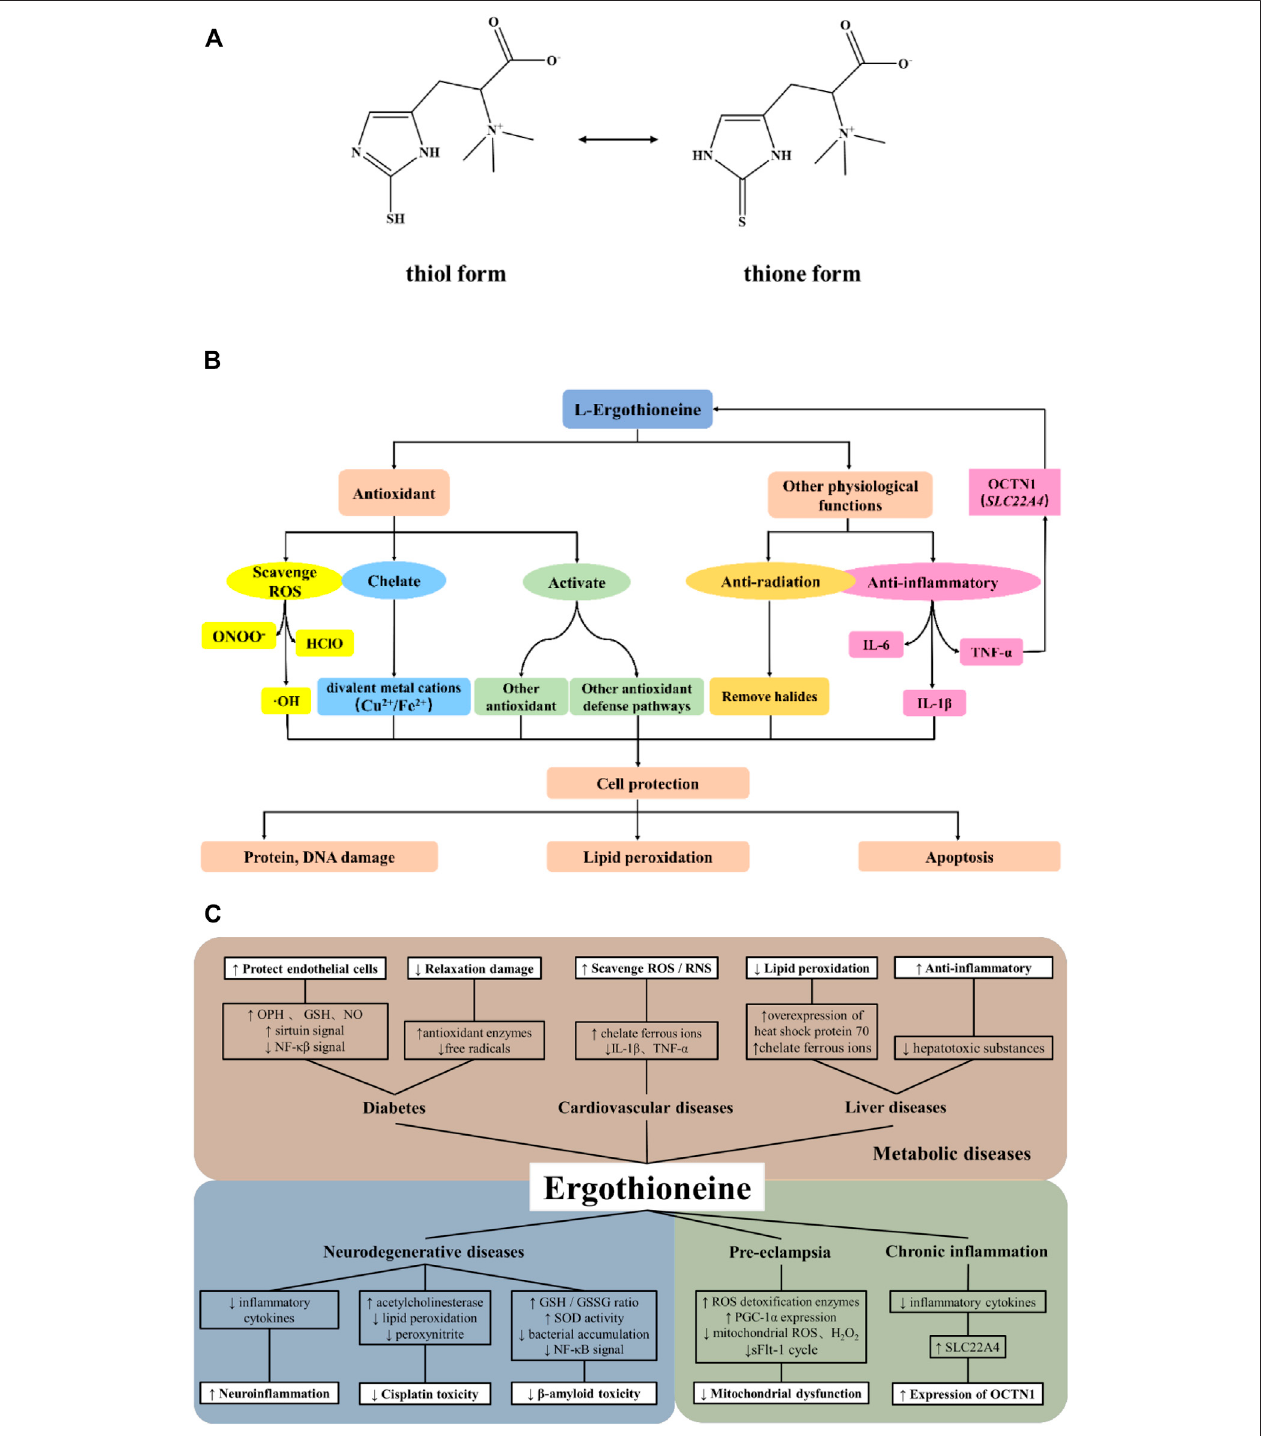
FIGURE1| Antioxidantpropertiesandpotentialactionmechanismsofergothioneine. (A) .Chemicalstructureofergothioneine; (B) .Themainantioxidantproperties and cytoprotective effects of ergothioneine; (C) . Potential mechanisms underlying the relationships between ergothioneine and oxidative stress-related disease conditions.